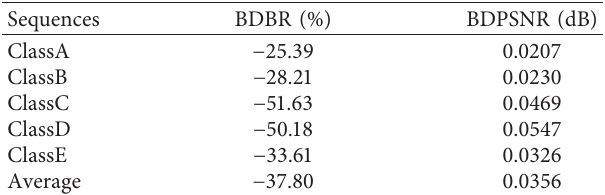
Table 5: Comparison of rate distortion performance by the ORC algorithm compared with the K0103